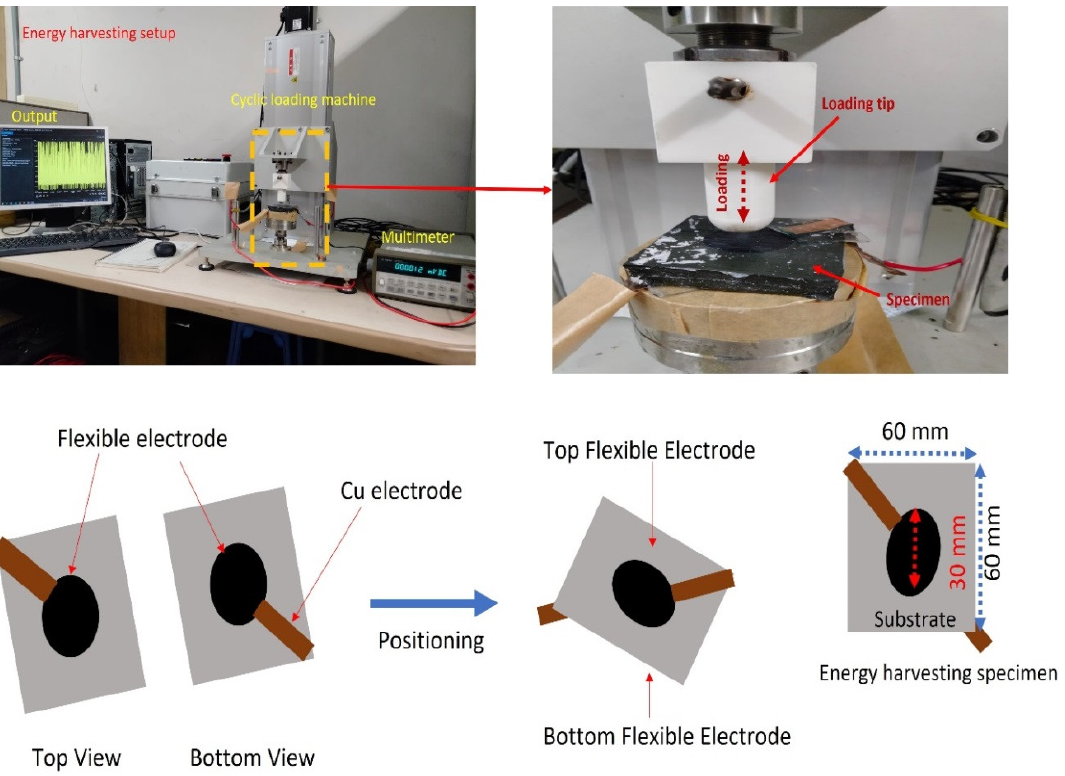
Figure 1. Piezoelectric energy-harvesting set-up with details on device dimensions and their as- sembly.